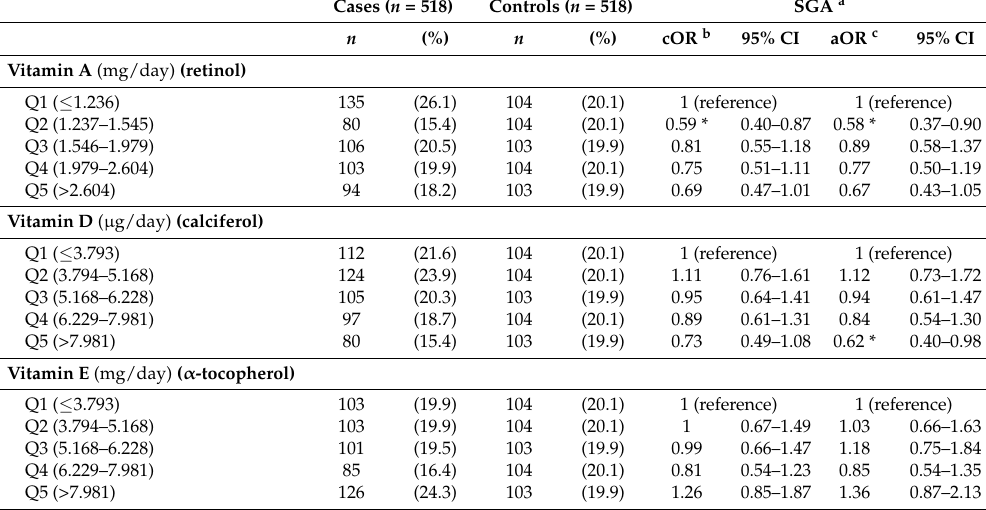
Table 2. Level of intake of liposoluble vitamins during pregnancy among healthy Spanish women ( n =